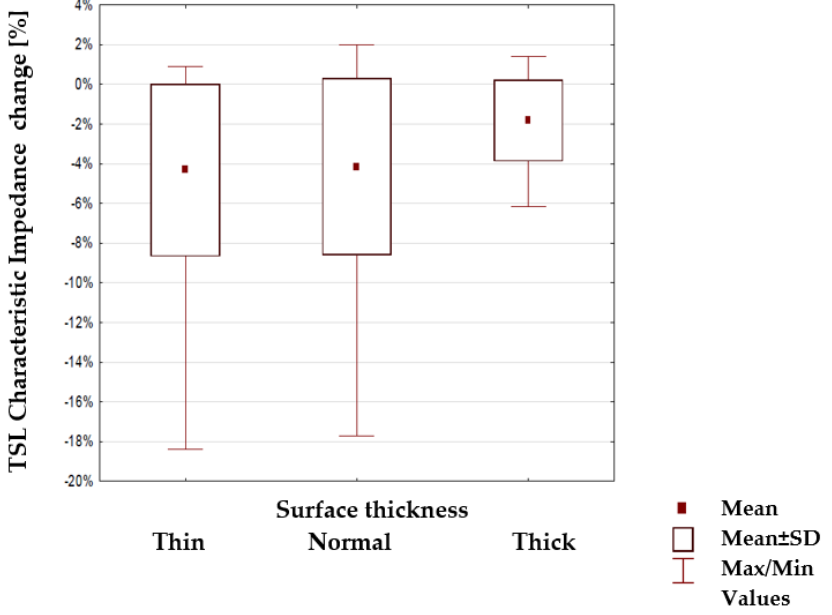
Figure 12. Changes in the line characteristic impedance under load for lines with a different thickness of the substrate.